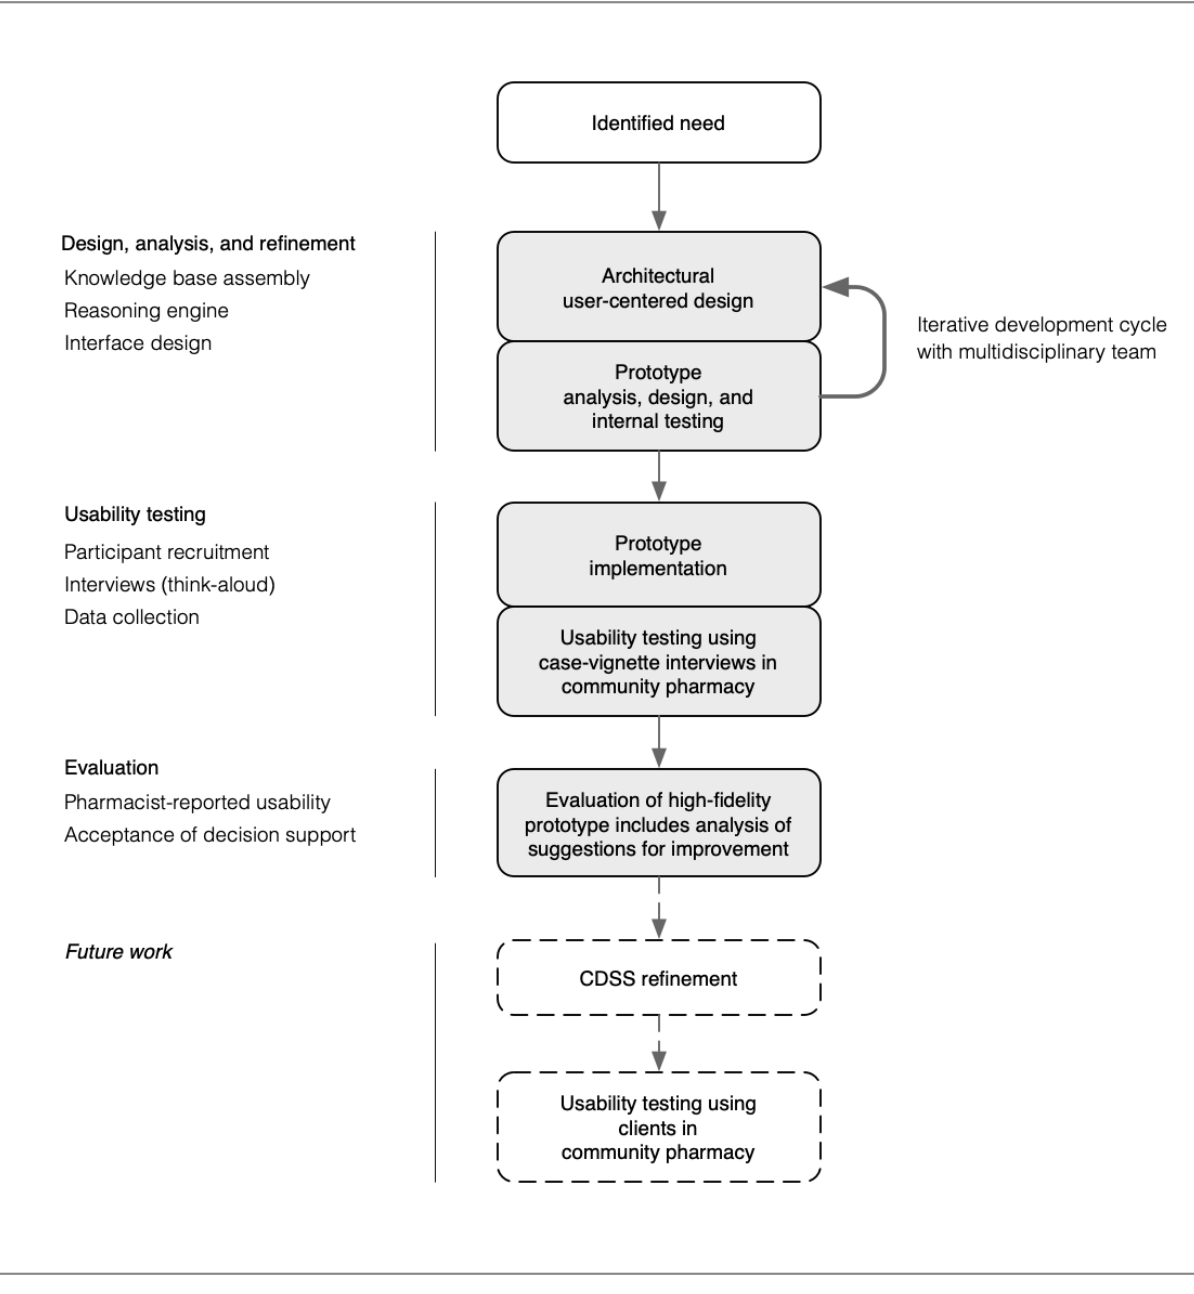
Figure 1. Clinical decision support system development based on prototyping and iterative testing (modified from Kushniruk et al). This study is represented by shading. CDSS: clinical decision support